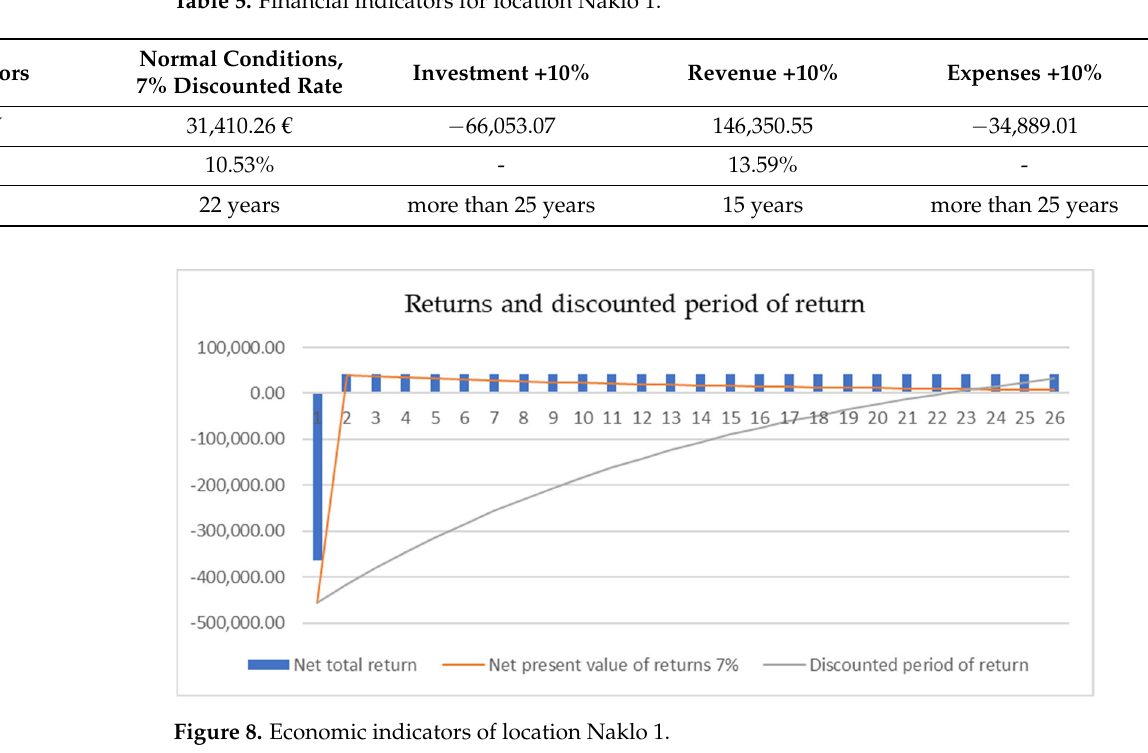
Table 5. Financial indicators for location Naklo 1.